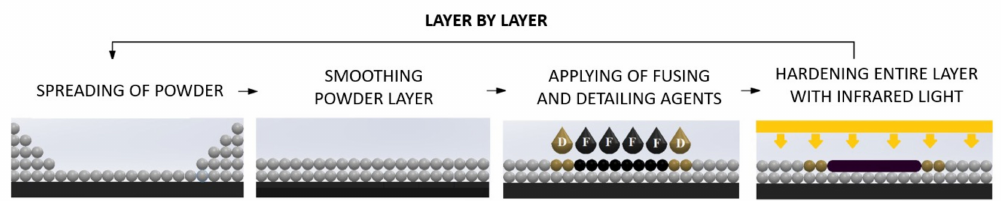
Figure 1. Multi Jet Fusion printing